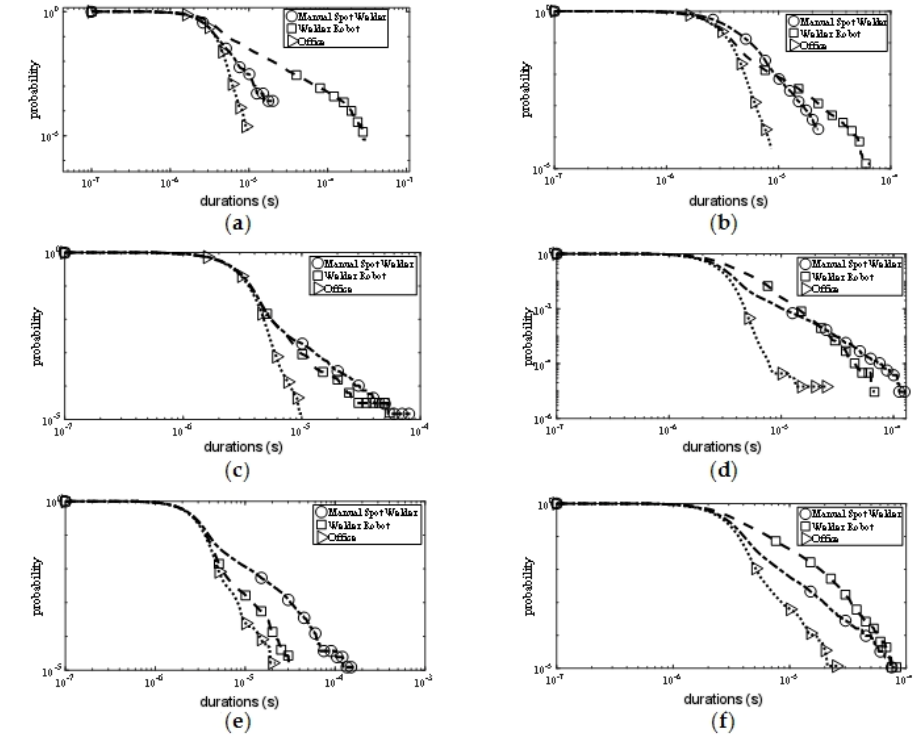
Figure 8. Pulse duration distribution (PDD) results. ( a ) PDD of vertical polarization at 315 MHz; ( b ) PDD of horizontal polarization at 315 MHz; ( c ) PDD of vertical polarization at 779 MHz; ( d ) PDD of horizontal polarization at 779 MHz; ( e ) PDD of vertical polarization at 916 MHz; ( f ) PDD of horizontal polarization at 916 MHz.